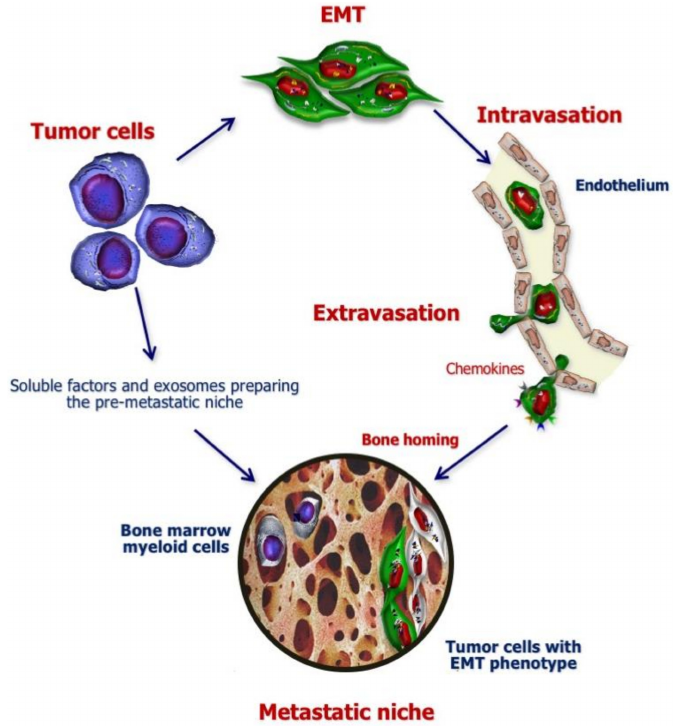
Figure 1. Role of primary breast cancer (BC) in the earliest phases of bone metastases (BM) establishment. In the majority of patients with BC, malignant cells are capable in advance to drive the skeleton colonization leading to BM formation. In fact, while BC cells undergo epithelial-to-mesenchymal transition (EMT) to acquire both migratory capability and invasiveness, concurrently they also organize premetastatic niches by releasing cytokines, growth factors and exosomes with the cooperation of myeloid cells from bone marrow. Thus, after invading the surrounding tissues, BC cells intravasate in blood and lymphatic vessels to reach distant anatomical sites, towards which they are attracted by the expression of specific chemokine receptors and other molecules involved in the bone-homing process. After their extravasation, BC cells can settle in bone microenvironment, competing with hematopoietic stem cells for niche